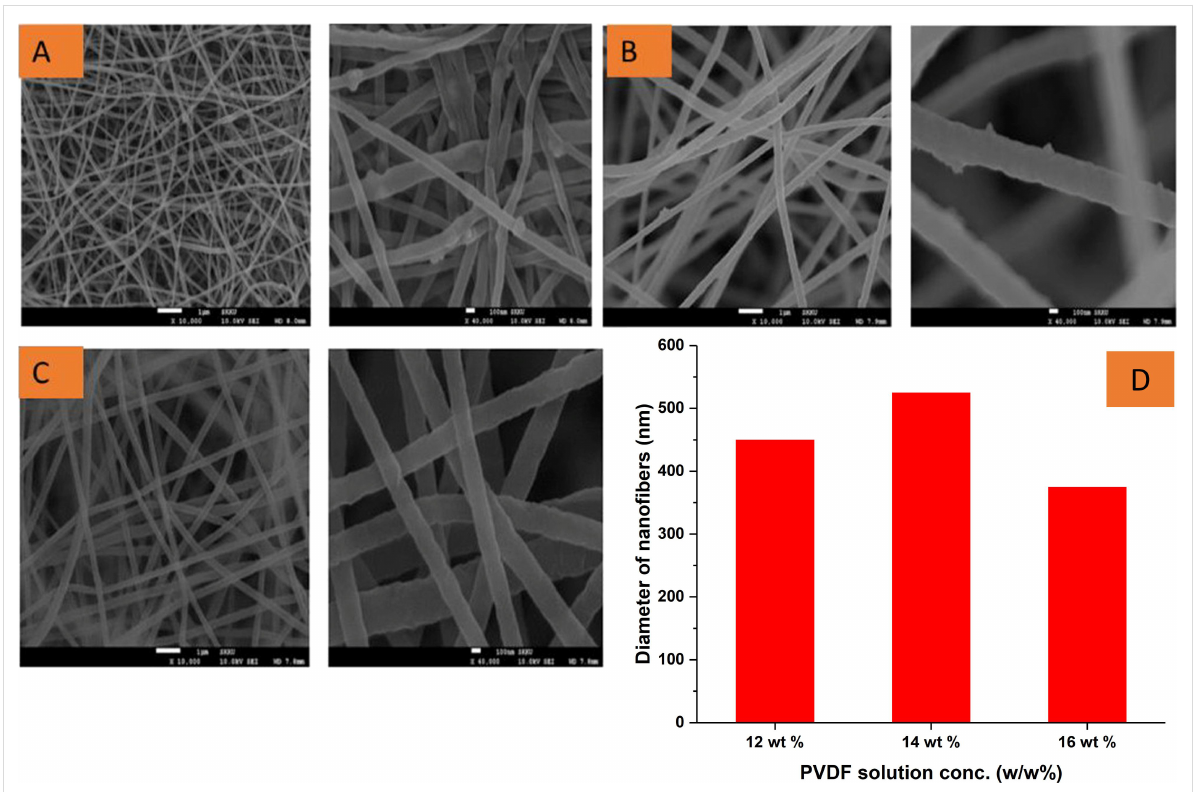
Figure 2: SEM images of nanofibers developed from 12 wt % (A), 14 wt % (B), and 16 wt % (C). PVDF solution and average diameter variation of nanofibers against different solution concentrations